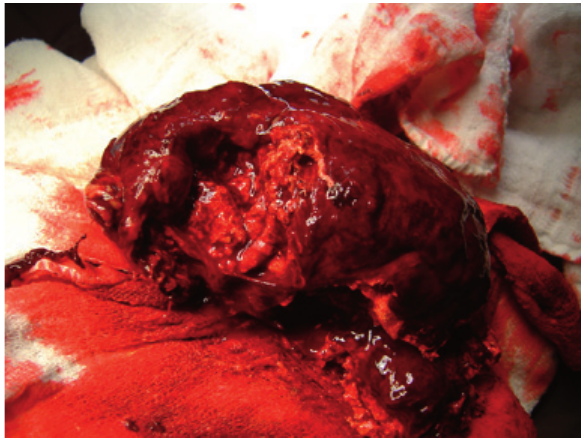
Figure 4 - Ruptured tumor – case 4: surgical findings of a ruptured renal